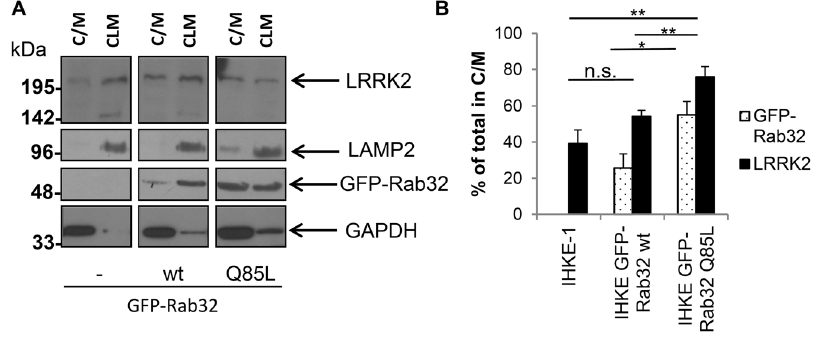
Figure 6. Subcellular fractionation analysis of endogenous LRRK2 in IHKE-1 cells overexpressing GFP-Rab32 wt or GFP-Rab32 Q85L. (A) IHKE-1 cells either untransfected (-) or stably overexpressing GFP-Rab32 wt or GFP-Rab32 Q85L were mechanically disrupted and fractionated by differential centrifugation. Fractions received either contained lysosomes and mitochondria (CLM) or cytosol and light membranes (C/ M). Western blot analysis to detect the lysosomal marker LAMP2, GAPDH, Rab32 and LRRK2 were performed with the fractions derived from the different IHKE-1 cells. (B) Quantification of Western blot signal intensities using the gel analyzer functionality of ImageJ. The signal intensity for both the C/M and the CLM fraction was added and set to 100%. The graph shows the % of GFP-Rab32 and endogenous LRRK2 in the C/M fraction of the different cell lines. n=6 independent experiments. Error bars represent S.E.M.; n.s.=not significant; *=p , 0.05; **=p , 0.01.